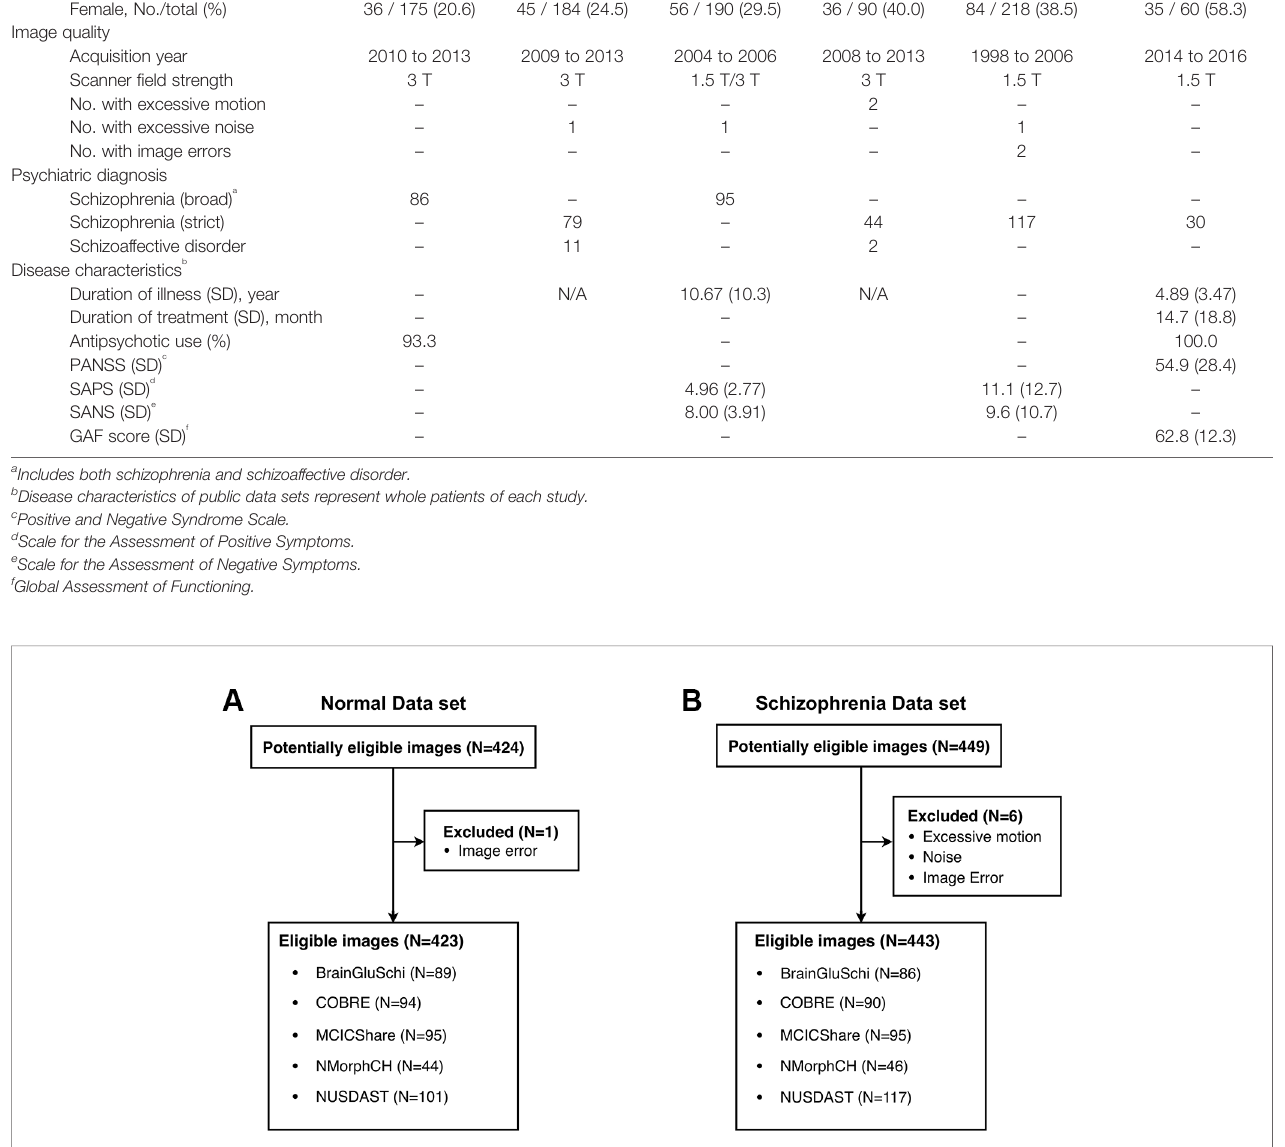
FIGURE 1 | Five public MRI data sets for the detection of schizophrenia through a deep learning algorithm. (A) Normal data sets consisted of structural MR images obtained from healthy control subjects. (B) Schizophrenia data sets consisted of structural MR images obtained from schizophrenia and schizoaffective disorder